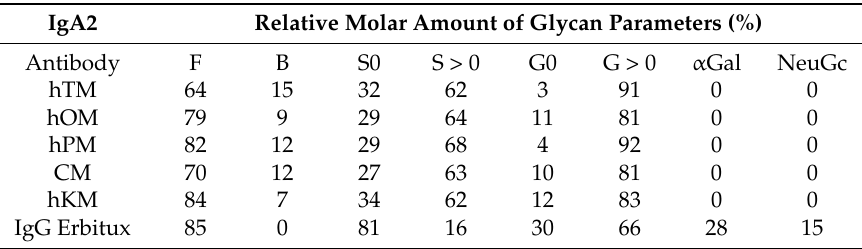
Table 2. Relative abundance of glycan parameters for complex-type N- glycans. IgA2 Relative Molar Amount of Glycan Parameters